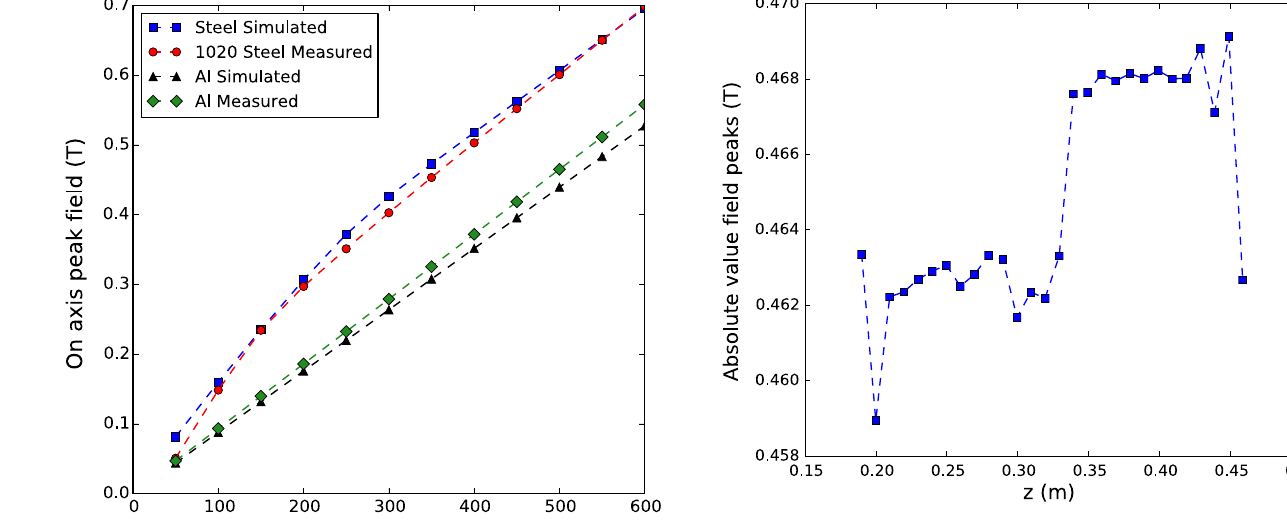
FIG. 24. Absolute value of the magnetic field peaks of the 20 mm-period Al prototype. The step represents a 100 μ m change in the winding bore of the mandrel that was found on both